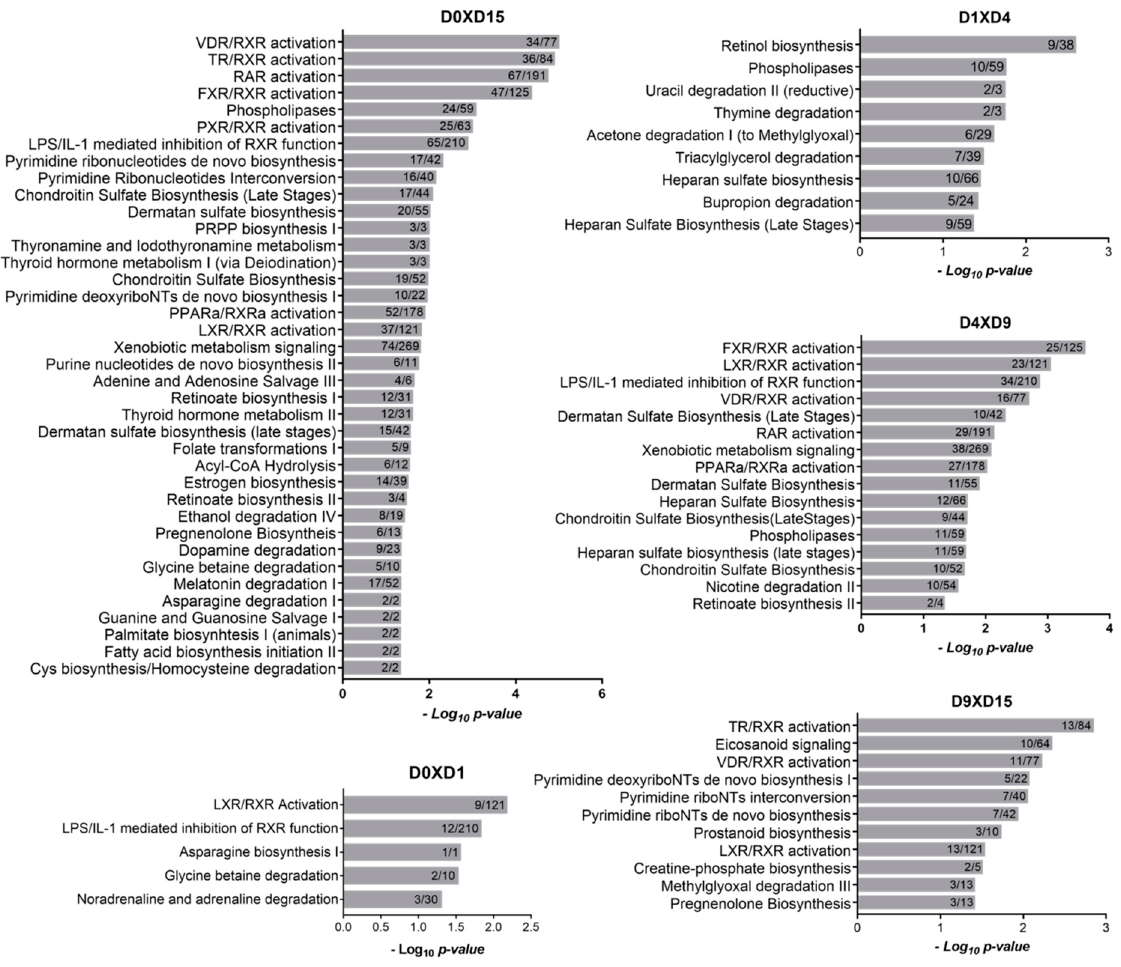
Figure 2. Metabolism-related canonical pathways enriched in in vitro cardiac differentiation. Enriched Ingenuity Pathway Analysis (IPA) canonical pathways related to metabolism at each in vitro cardiac differentiation transition. The ratios between the number of DEGs found and the total number of genes of each canonical pathway are shown inside the bars.